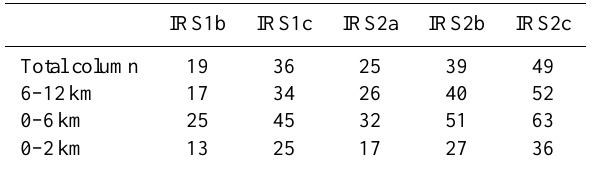
Table 6. Improvement in terms of errors expressed in relative gain (%) from the IRS1a-IASI scenario for different atmospheric layers: CO total column, 6–12km column, 0–6km column and 0–2km col- umn.